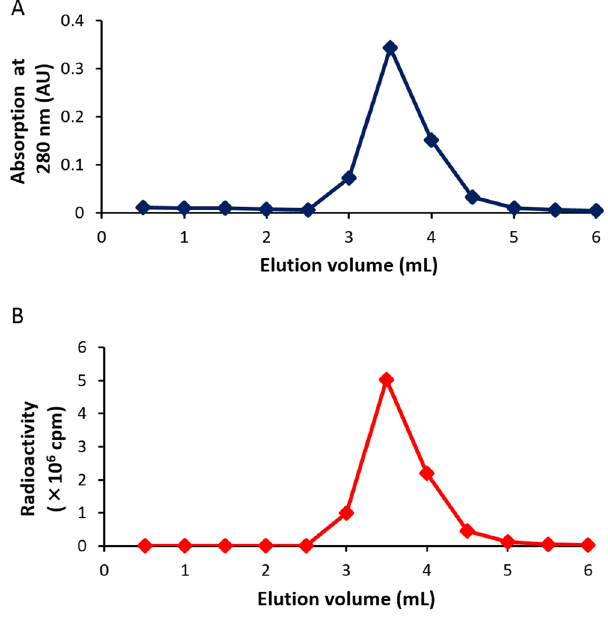
Figure 12. Size-exclusion chromatography of [ 125 I] 4 -trastuzumab by the detection of absorbance (280 nm) ( A ) and radioactivity ( B